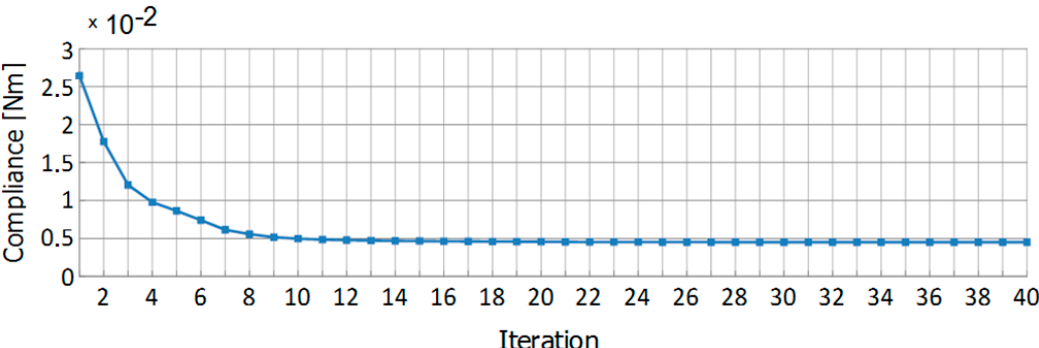
Figure 37. Iteration history for the structure under two-load case.